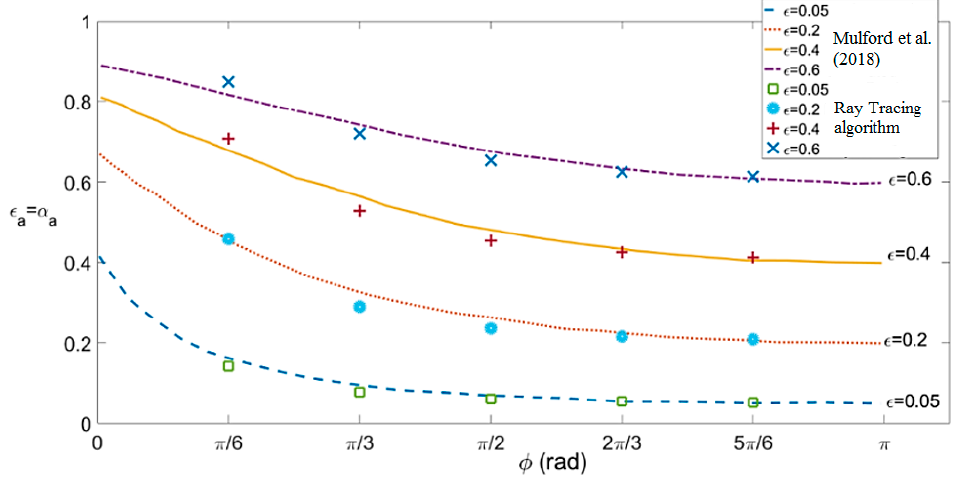
Figure 12. Average apparent emissivity or absorptivity calculated for diffuse irradiation [8].